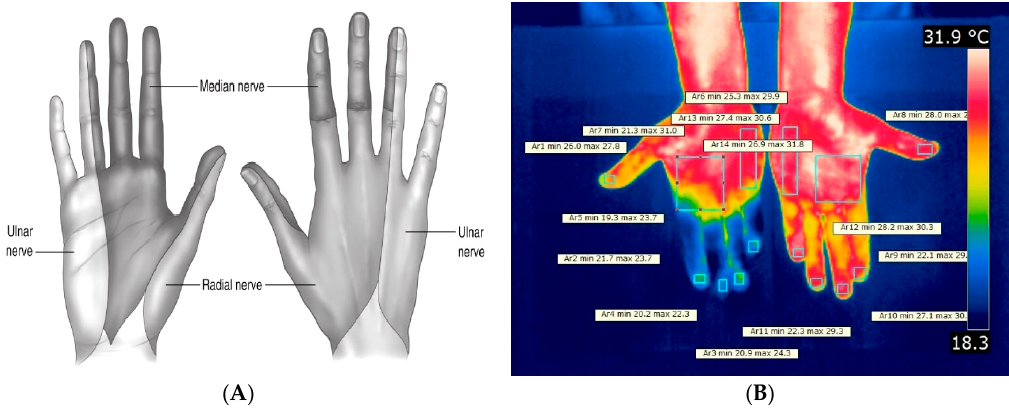
Figure 2. ( A ) Sensory mapping model of the peripheral cutaneous innervation of the hand on the dorsal and palmar surfaces. The figure shows the innervations for the ulnar nerve, radial nerve, and median nerve [34]; ( B ) Thermographic image of the palms of the hands, with the anatomical regions delineated showing the corresponding temperatures for each area.